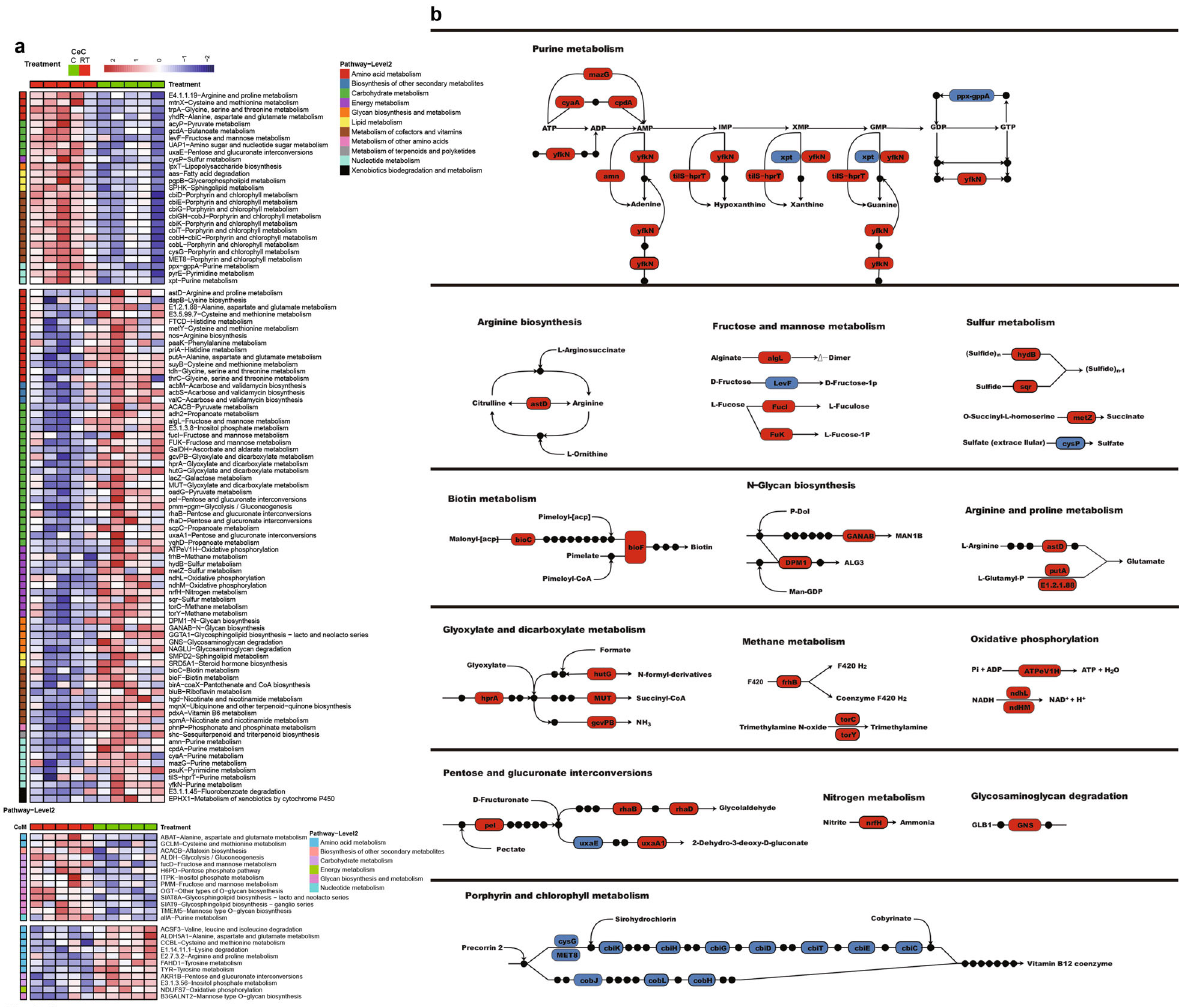
Fig. 4 Cold exposure changes the function of microbiota genes involved in metabolism in the cecum, as indicated by the KO genes and KEGG pathway modules. a Heatmap differences at the metabolic level of the microbiota of the contents and epithelial surface of the cecum. b Representative pathway with the highest difference in abundance. Red indicates higher expression of genes, and blue indicates lower expression of genes, in piglets under cold stress compared with RT. CeC and CeM represent the cecal content and the cecal epithelial surface respectively. The data are the means ± SEMs ( n = 5 per